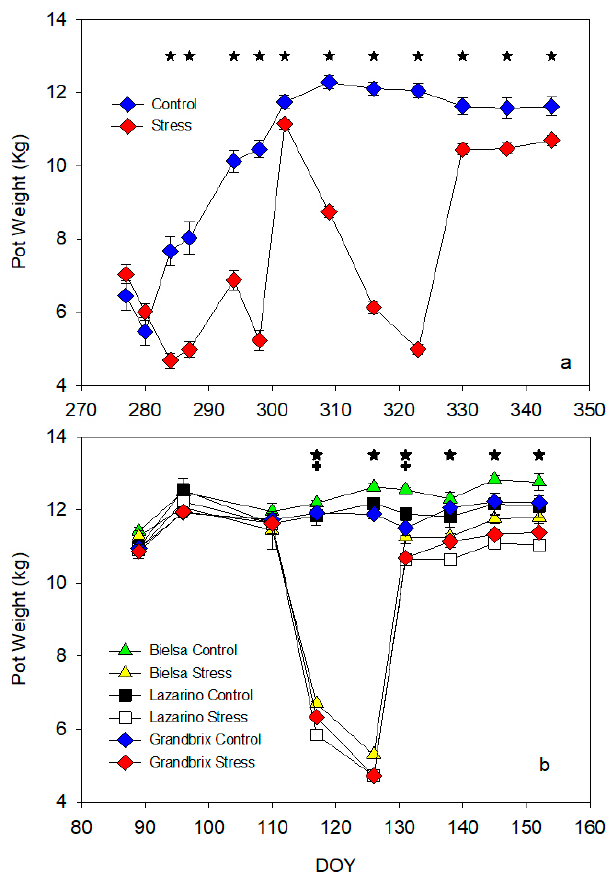
Figure 2. Pattern of pot weight along the autumn ( a ) and spring ( b ) cycles. Each symbol is the average of 4 (autumn cycle) or 3 (spring cycle) data. Vertical bars represent the standard error. Asterisks (irrigation treatments) and crosses (cultivars) indicate the date when significant differences were found ( p < 0.05).